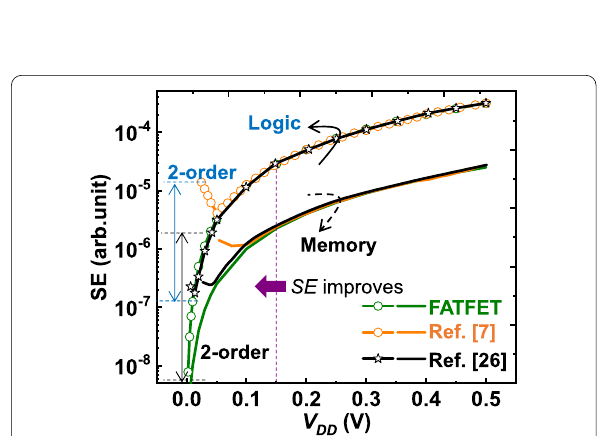
Fig. 12 Comparison of SE variation with supply voltage scaling. It clears that the proposed structure (FATFET) reduces SE by 2-order (both in logic and memory environments) due to its high I on / I off